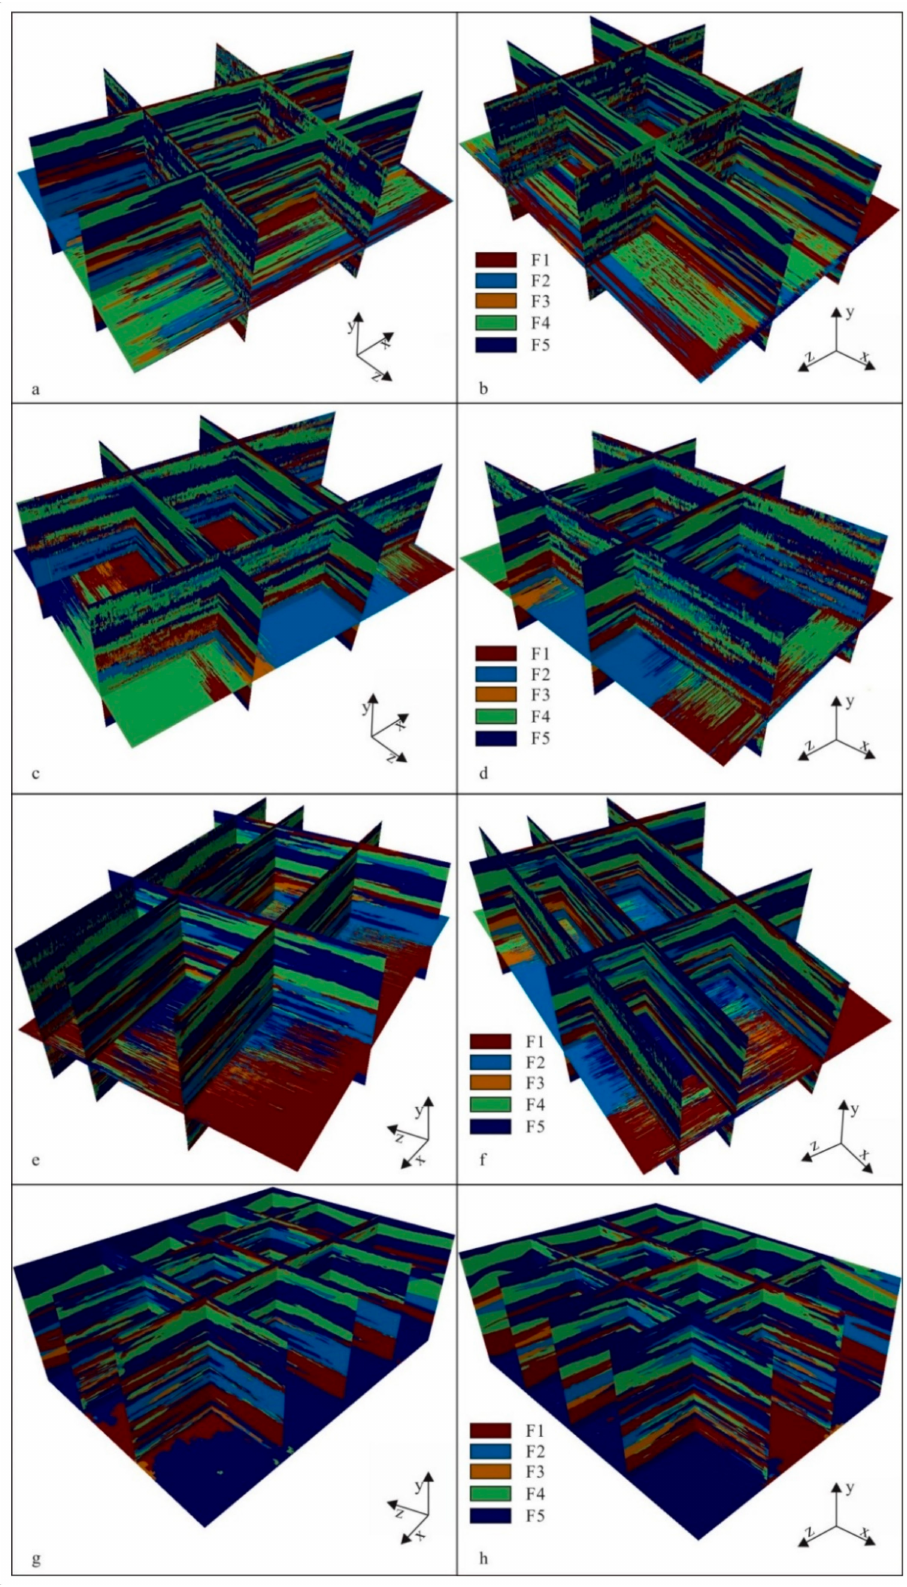
Figure 10. Simulated results of four types of sequences in Figure 9. ( a , b ) The simulated results of Figure 9b; ( c , d ) the simulated results of Figure 9a; ( e , f ) the simulated results of Figure 9c; ( g , h ) the simulated results of Figure